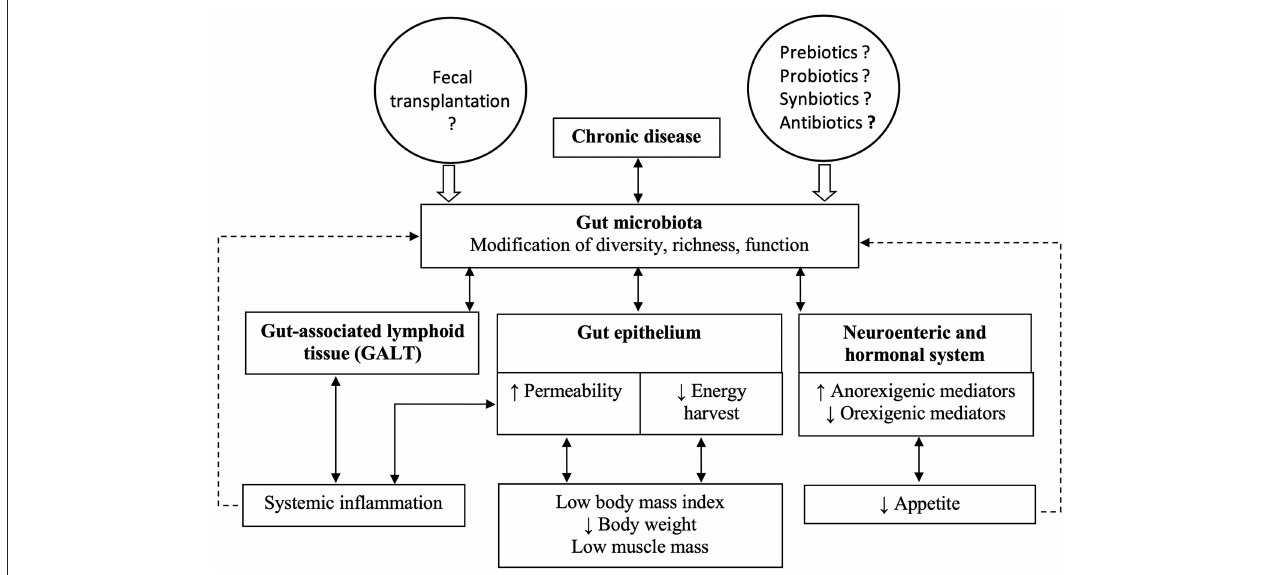
FIGURE 1 | The figure summarizes hypothetical links between chronic diseases and cachexia, based on the opinion of the authors. Chronic diseases lead to changes in gut microbiota composition and function, which in turn affect the components of the gut barrier. The combined modifications of the gut epithelium, the gut-associated lymphoid tissue and the enteric nervous system could result in